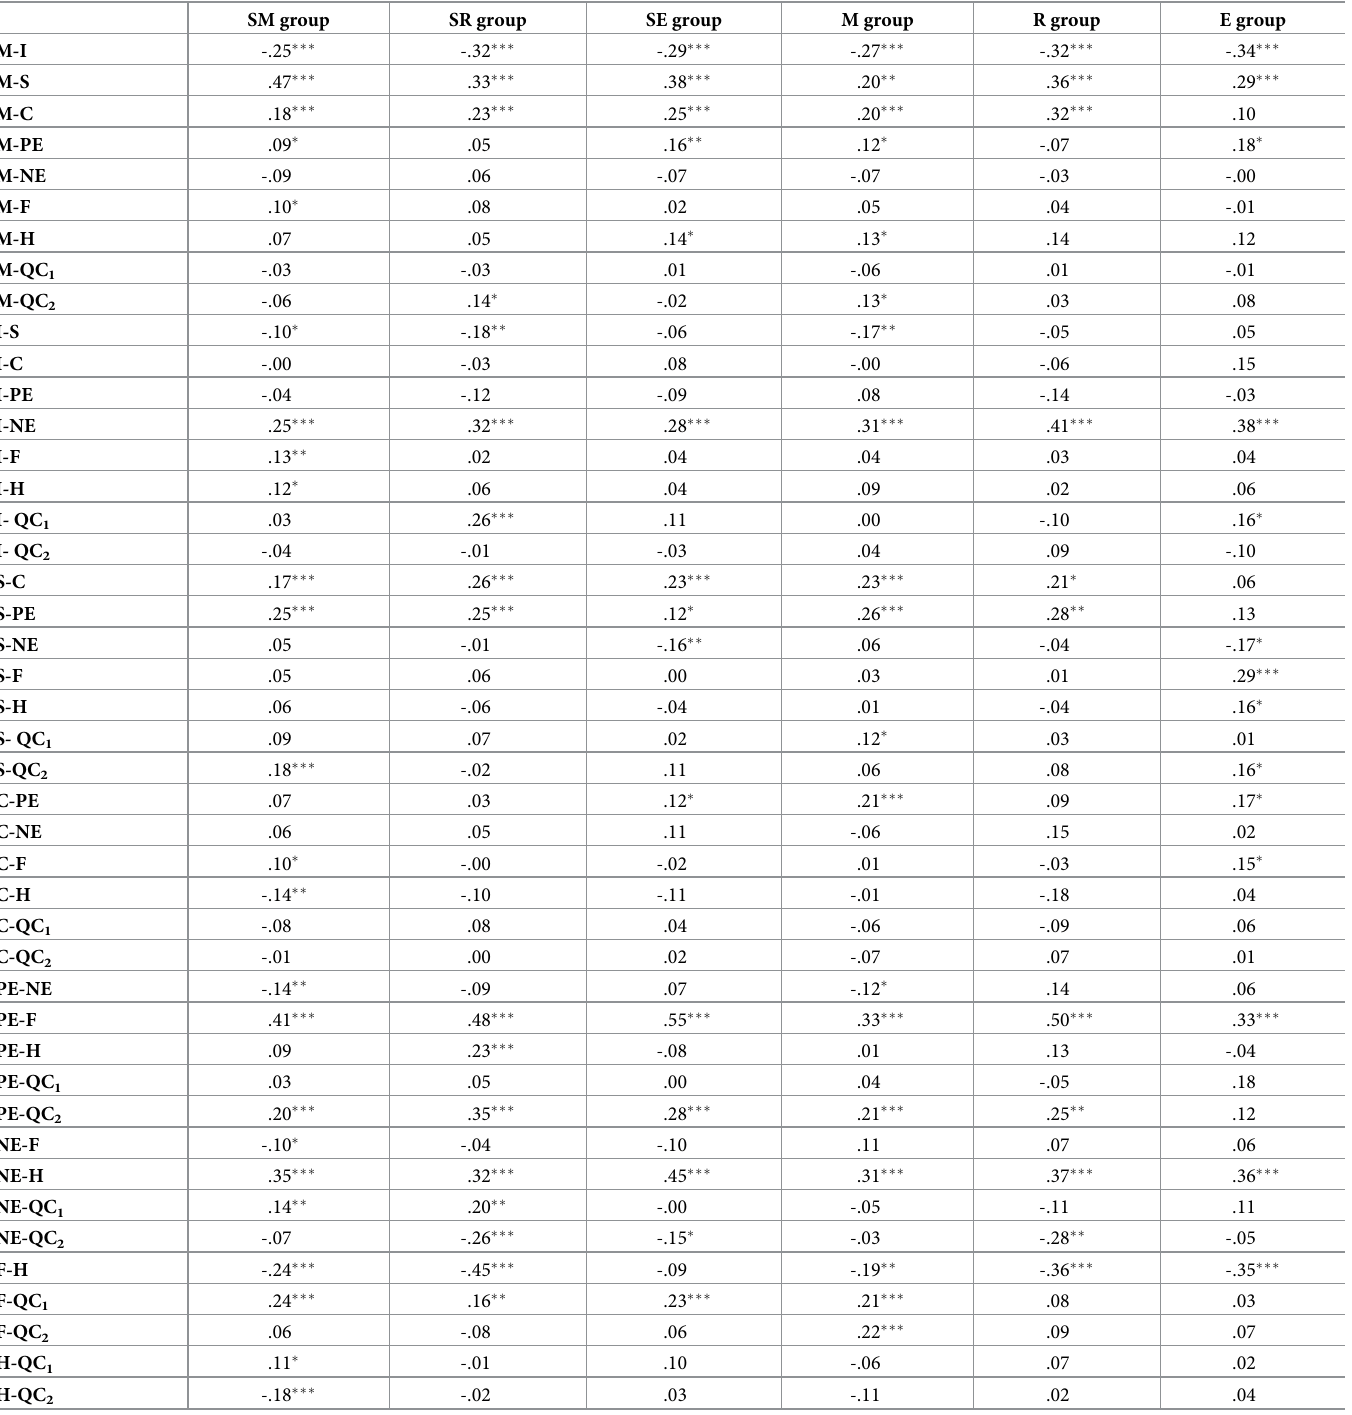
Table 3. Partial correlations between all the variables in the six